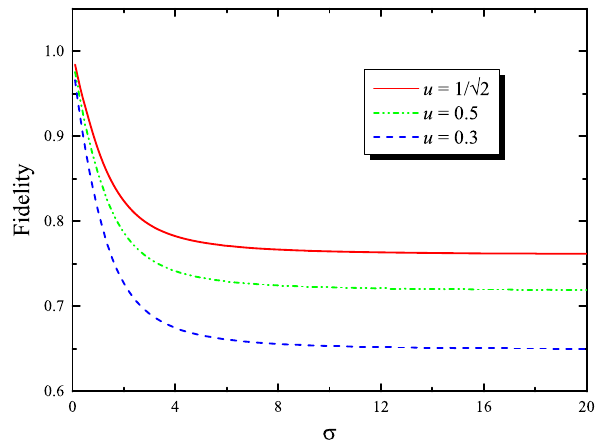
Fig. 11 The fidelity of quantum teleportation, F 3 as defined in (88), as a function of the rapidity σ of the expansion of the spacetime. The parameters of the two originally entangled qubits A and B are the same. The energy gap of each of them is (cid:15) = 2, the inner product of the mode functions, defined in Eq. (21), is μ = 0 . 1. The mass of the scalar field particle is m = 0 . 01. The volume of the expansion is chosen to be ε = ε max = 19 , 999 . 5. The state teleported from qubit C to B is u | 0 (cid:7) + v | 1 (cid:7)